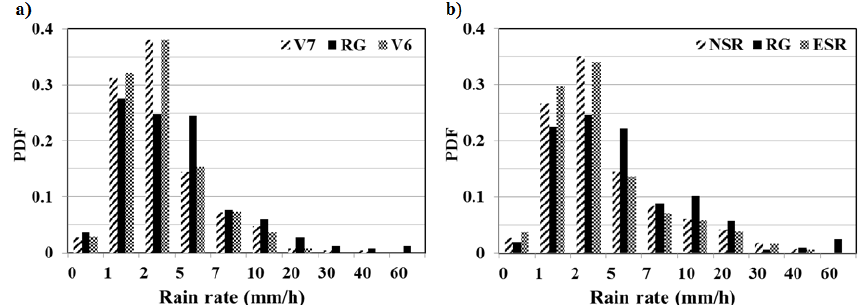
Figure 4. (a) Probability distributions of rain rates for V7 and V6 comparison of non-null TRMM 2A25 near-surface rain rate (NSR) estimates and average raingauge rain rates for near-nadir pixels (scanning inclination angles ranging from 0 to 9 ◦ ) during the period 1 June 2008– 31 May 2013; (b) probability distribution of non-null TRMM 2A25 V7 surface rain rate products (estimated surface rain rate (ESR) and NSR) and average gauge rain rates during the period 1 June 2008–31 May 2013. Raingauge rain rates are calculated using timescales of 10 (RG0XX and RG1XX) and 30min (RG3XX) corresponding to the interval centered at the time of satellite